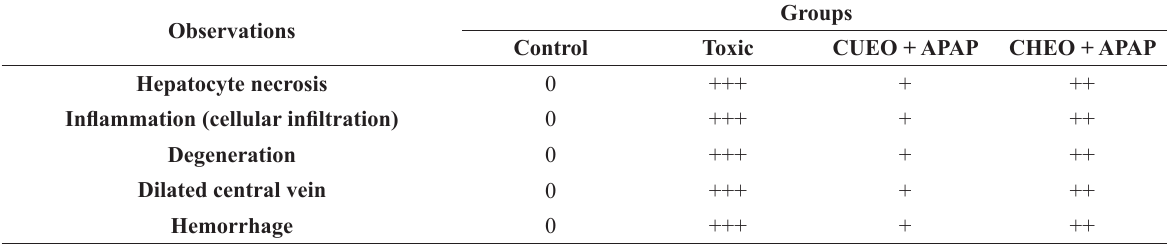
Impact of repeated CUEO or CHEO administration on histopathological features of acute APAP